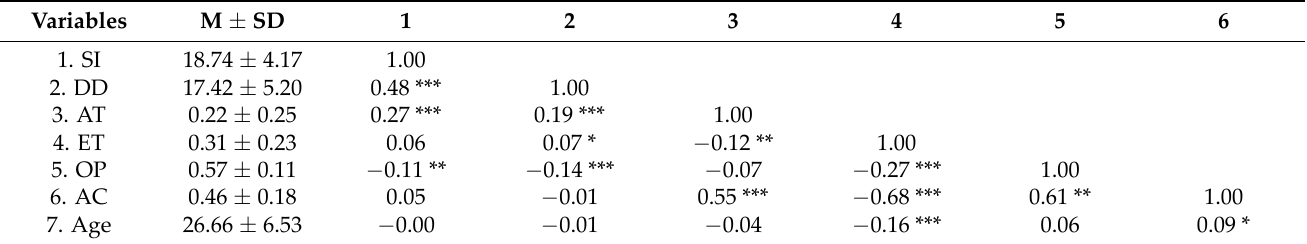
Table 4. Mean, standard deviation, and correlation coefficient of measured variables ( n =